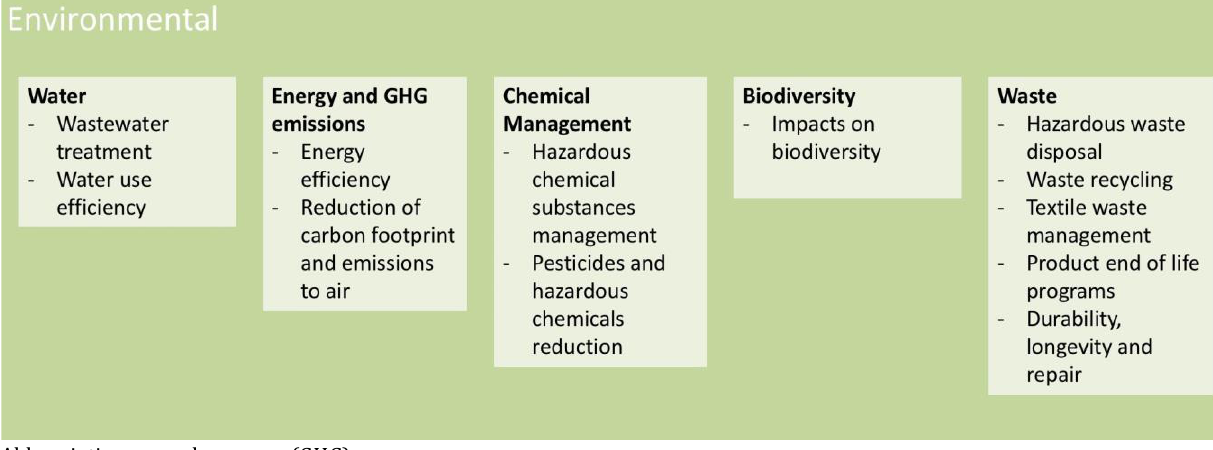
Figure 1. Summary of textile and apparel environmental sustainability issues by aspect and sub-aspect MSIs in Fashion Supply